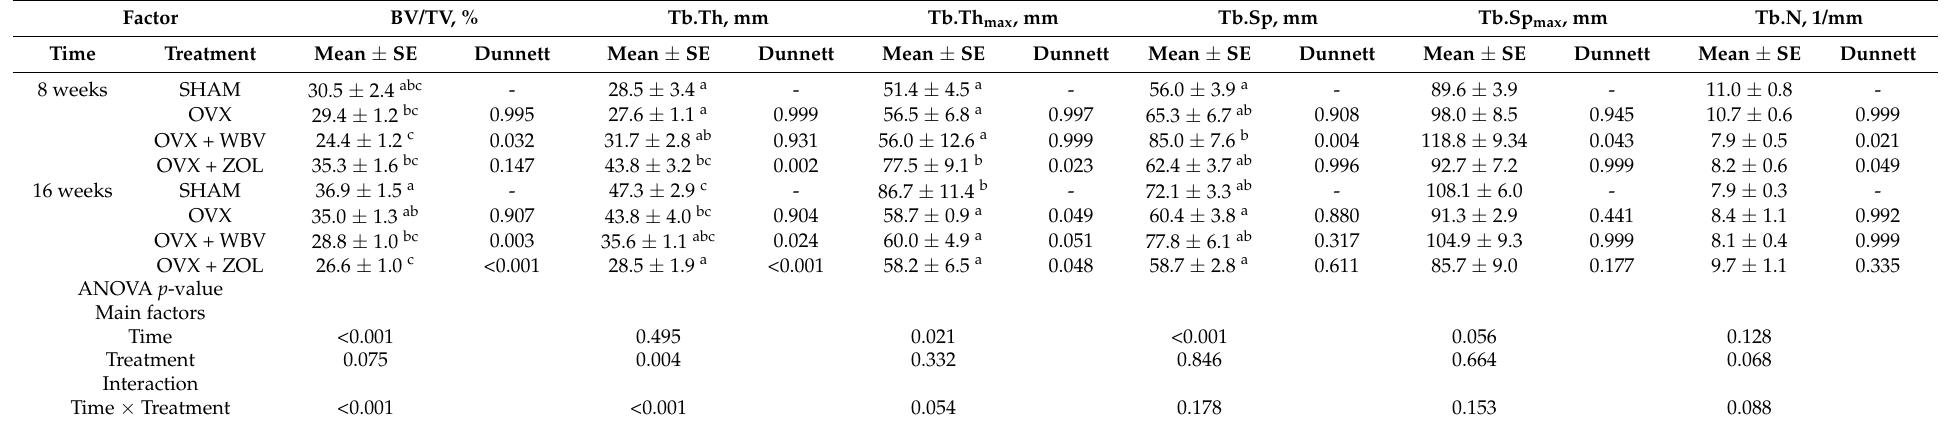
Table 1. The trabecular bone histomorphometry in femur epiphysis in the study groups.